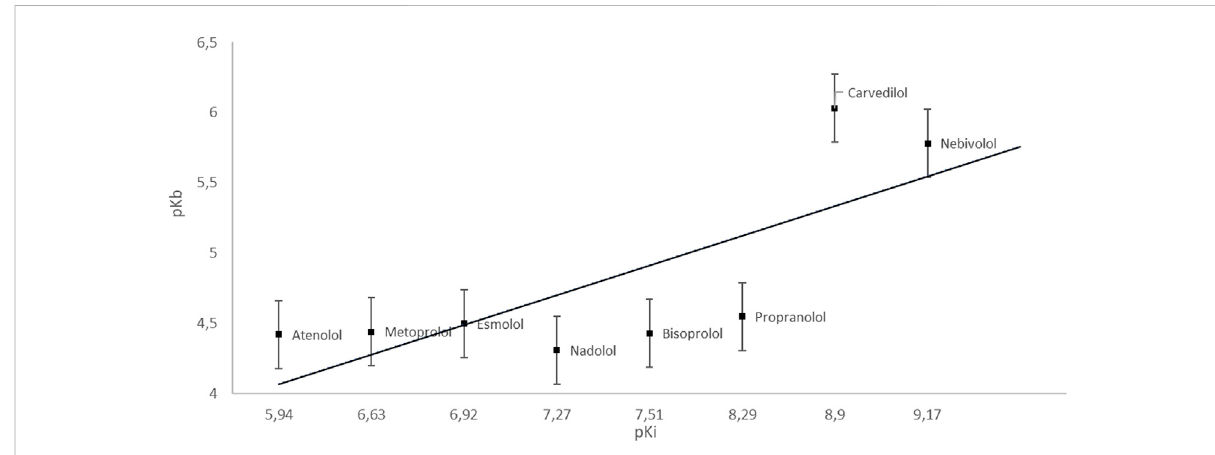
TABLE 1 Characteristics of individual β -blockers (Murakami et al., 2005; Gaciong and Narkiewicz, 2008; Maurer, 2010). Drug Cardioselectivity ISA Lipophilicity t1/2 (h) Drug excretion Atenolol ++ Bisoprolol Carvedilol